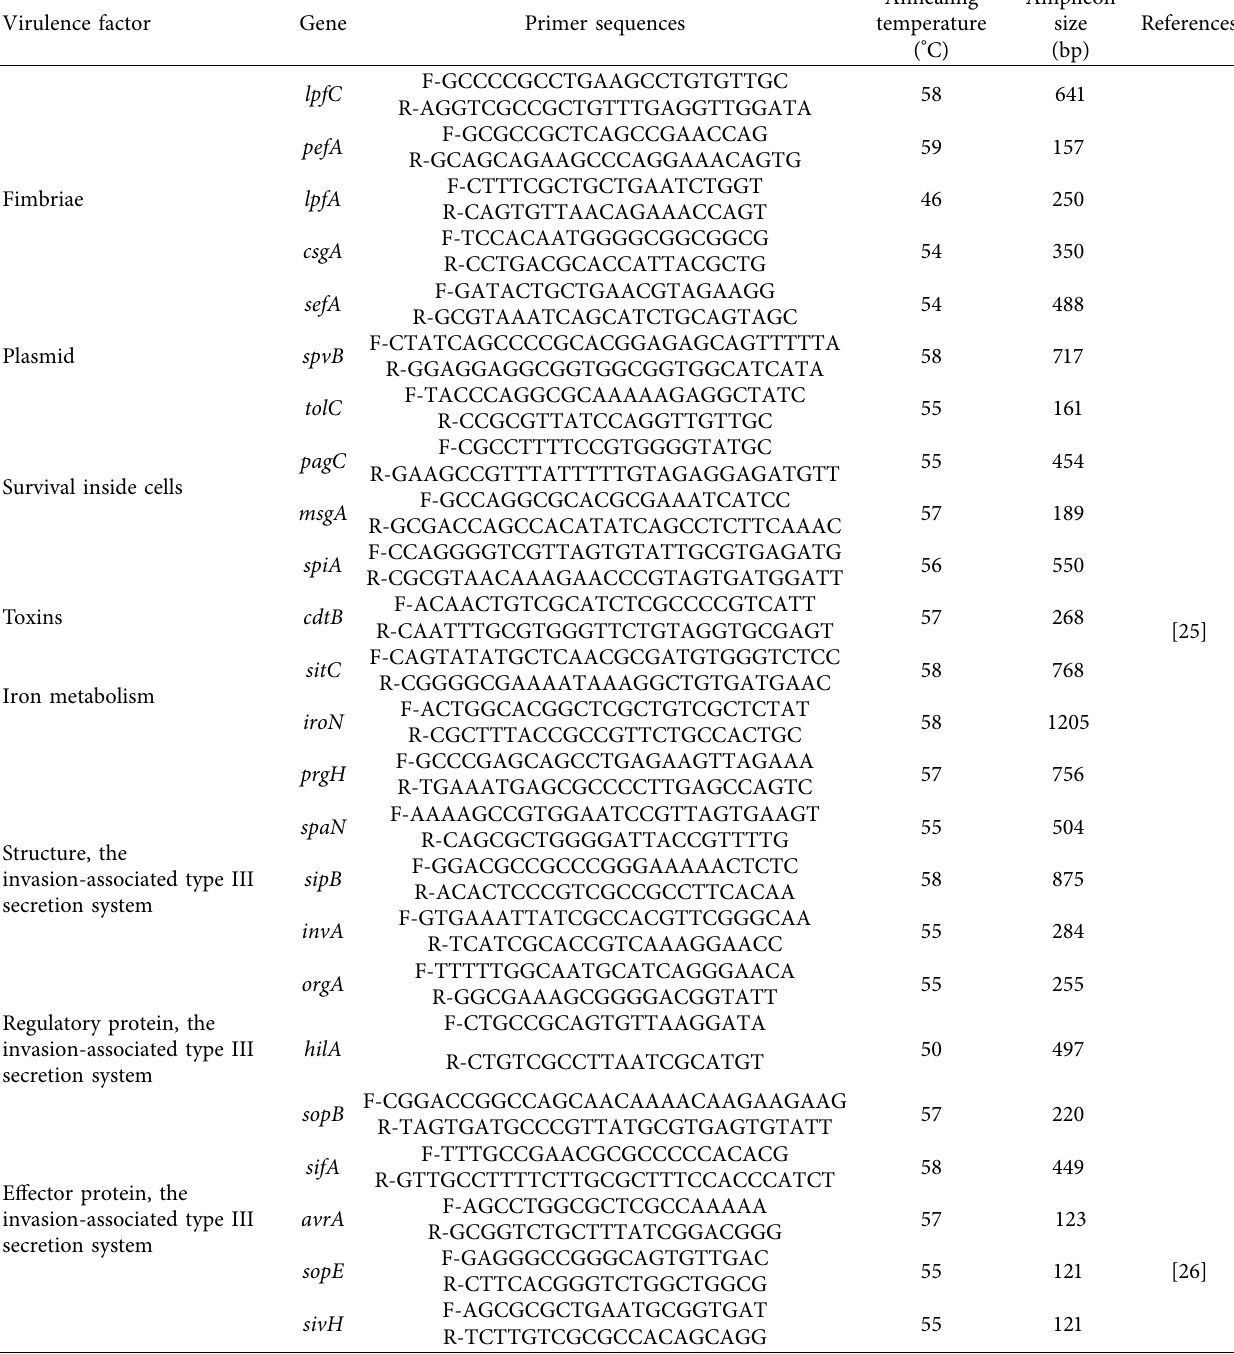
Table 1: Primer sequences for virulence genes in Salmonella